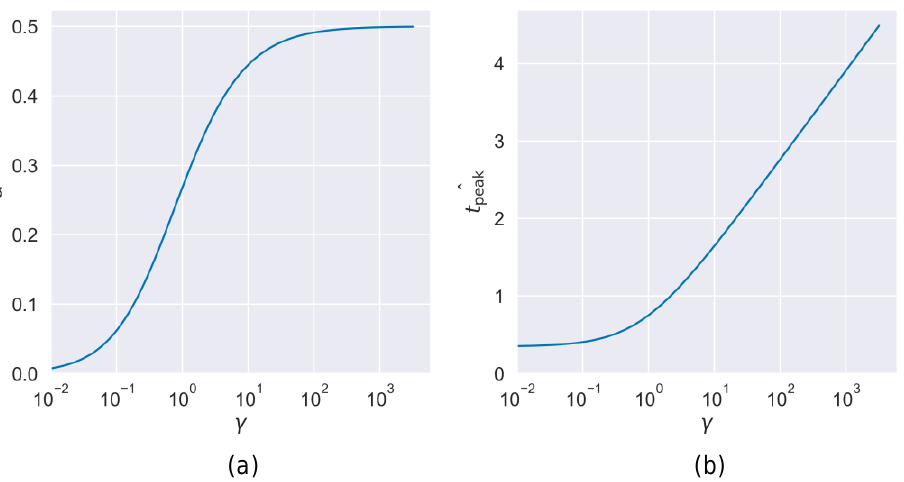
γ , α , and ˆ t peak